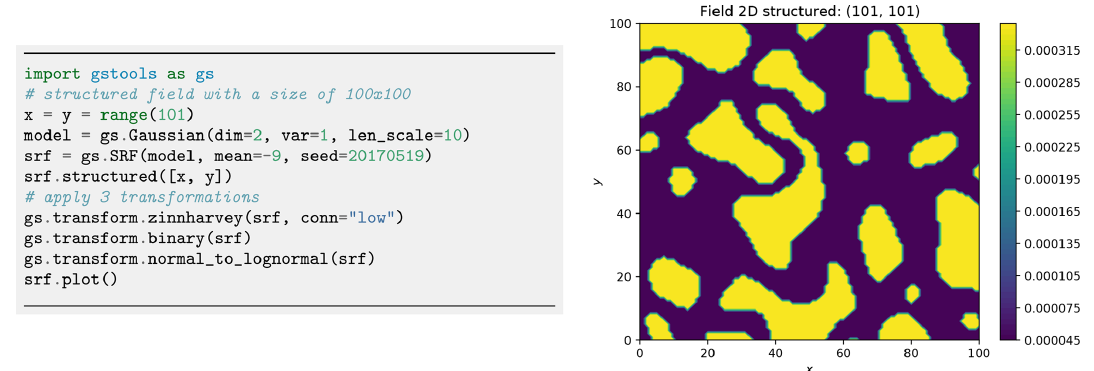
Figure 14. Example of a log-transformed binary field with the low values being connected by applying the zinnharvey , binary and lognormal transformations successively.